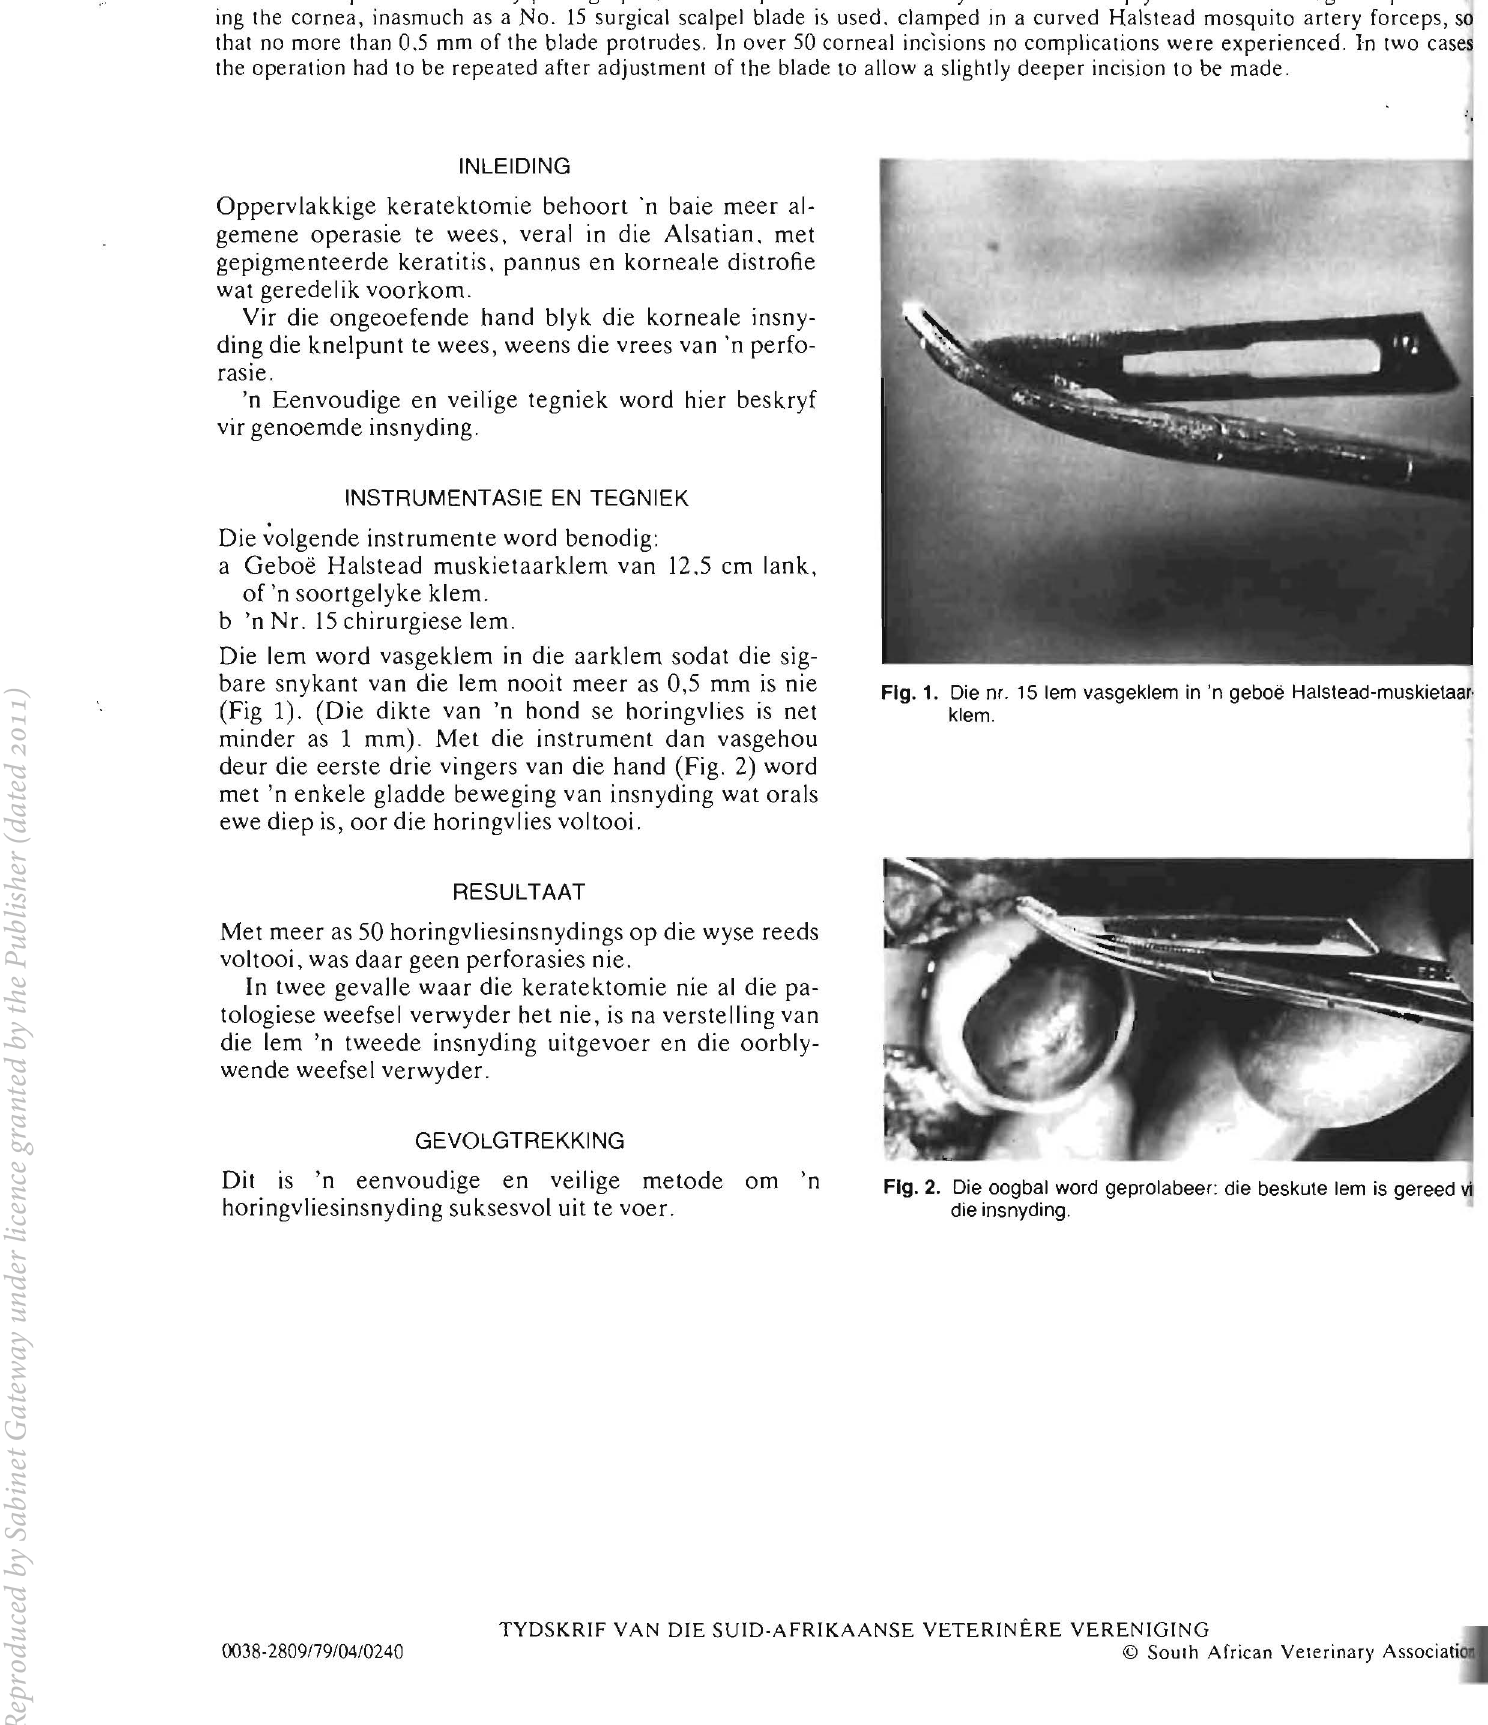
TYDSKRIF VAN DIE SUIO-AFRIKAANSE VETERINERE VERENIGING 0038-2809179/04/0240 © Soulh African Velerinary